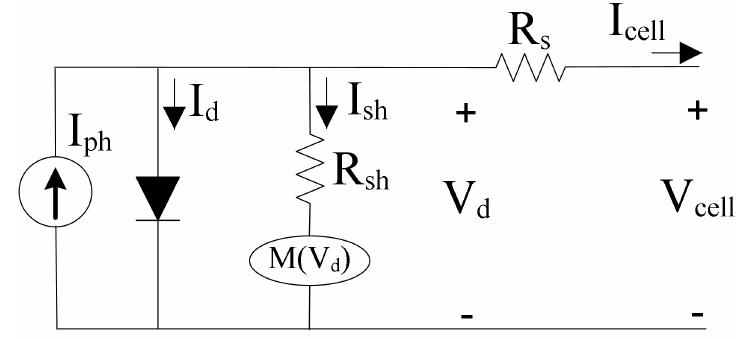
Figure 3. Circuit diagram of the Bishop